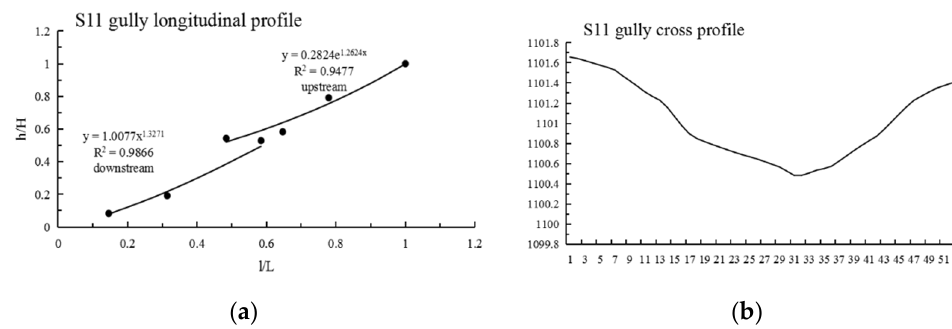
Figure 8. Longitudinal and cross profile fitting diagram of S11.